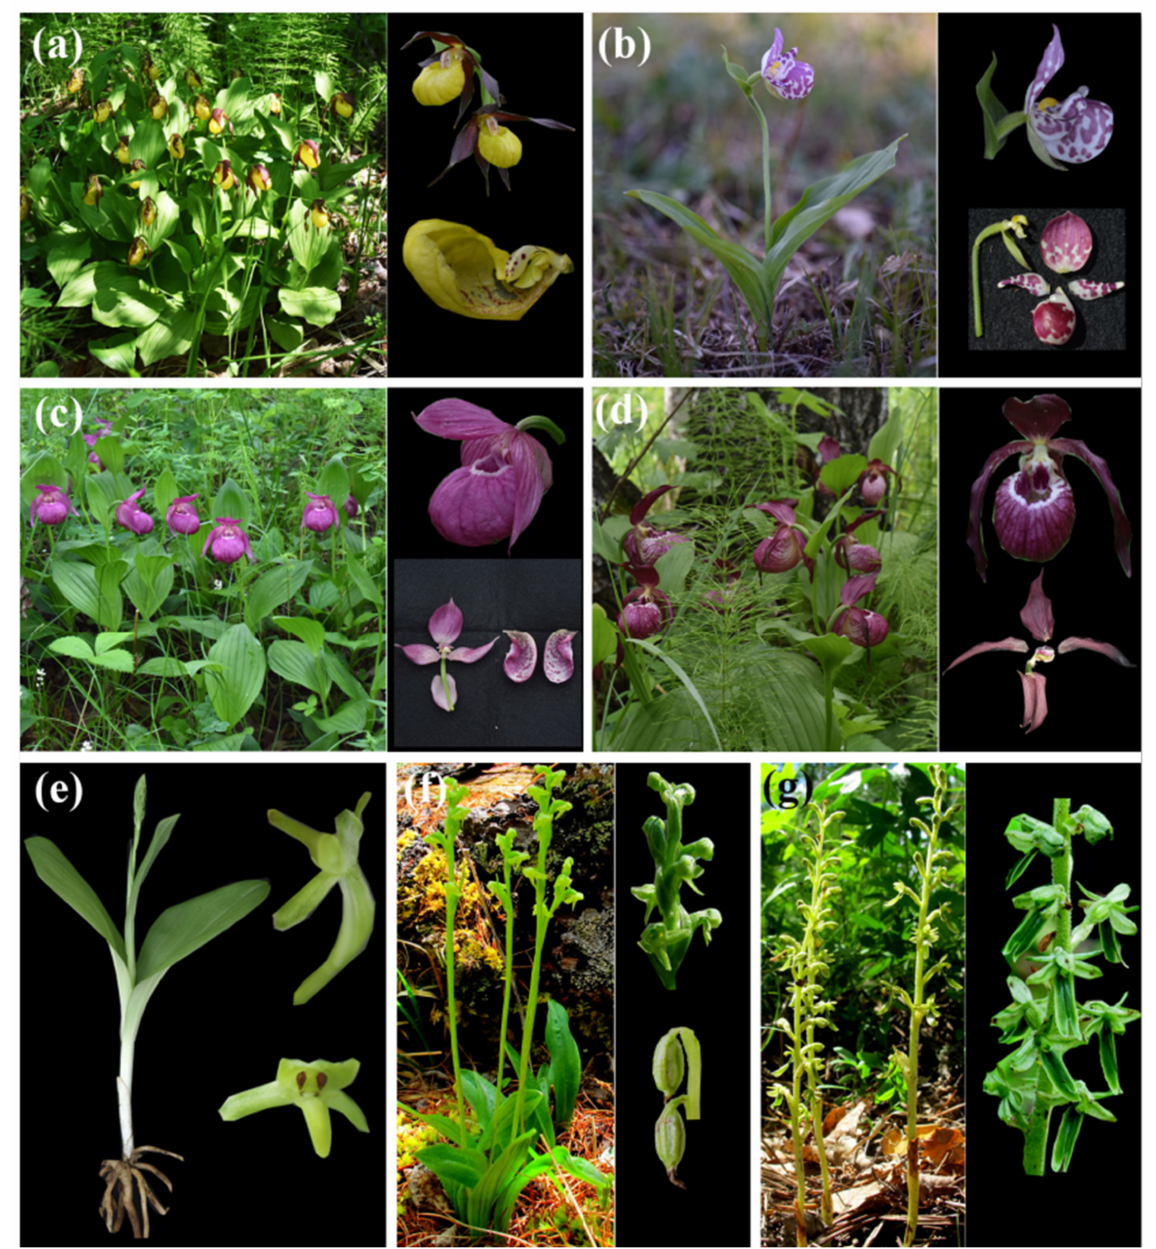
Figure 2. Representative taxa of Orchidaceae in Mongolia: ( a ) Cypripedium calceolus , ( b ) Cypripedium guttatum, ( c ) Cypri- pedium macranthos , ( d ) Cypripedium × ventricosum , ( e ) Platanthera fuscescens , ( f ) Platanthera oligantha , ( g ) Neottia camtschatea (Photos: ( a – d ) by Sh. Baasanmunkh, ( e ) by B. Oyuntsetseg and ( f , g ) by B.